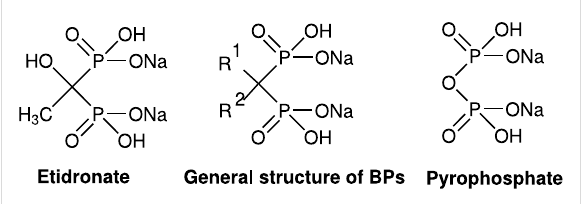
Figure 1: Structures of etidronate, pyrophosphate and general struc- ture of bisphosphonates.